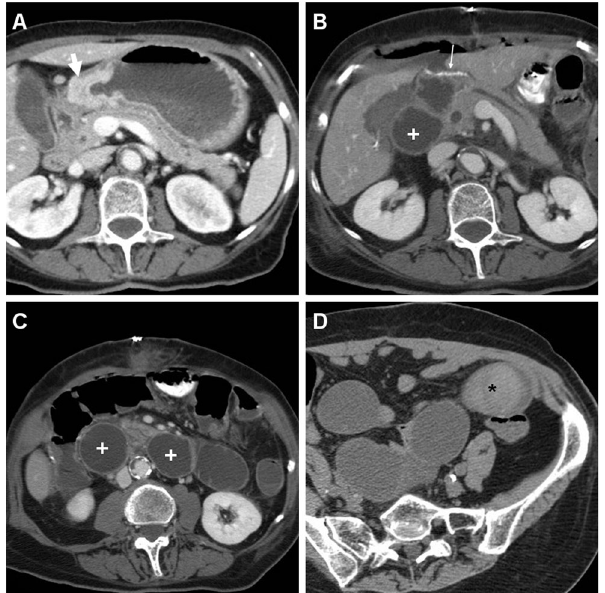
Fig. 15 A 72-year-old female with distal gastric carcinoma (thick arrow) as preoperatively depicted by CT (A) underwent total gastrectomy.